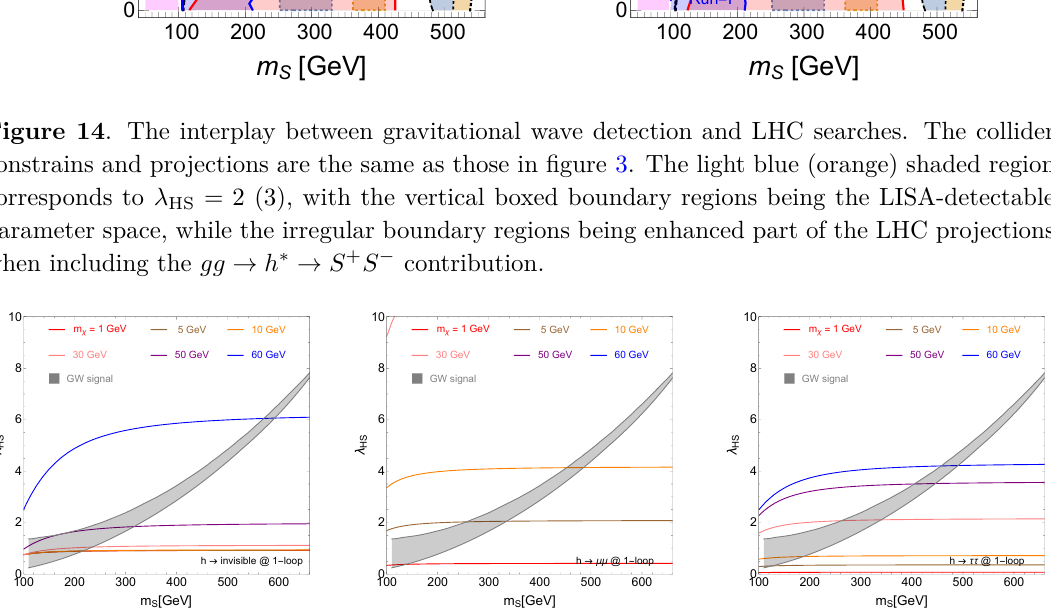
Figure 15 . The interplay between gravitational wave detection and future e + e − collider searches. The gray shaded region is the LISA detectable parameter space, varying λ from 0 to 4 π . From S left to right, we show the sensitivities for λ from future CEPC precision measurements, based HS on invisible Higgs decay branching ratio Br ( h → inv) = 0 . 3% , Higgs leptonic coupling precision reaches δκ 8 . 7% and δκ 1 . 5% µ < τ <